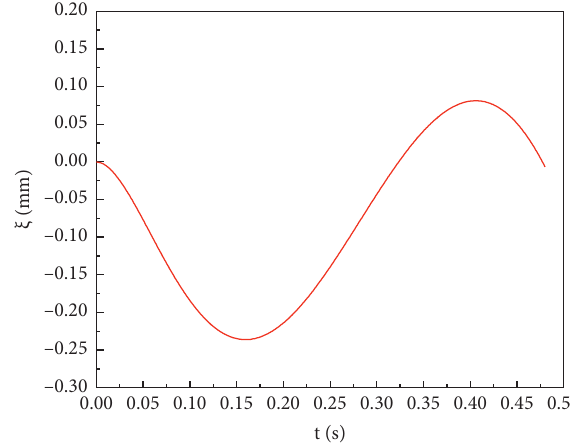
Figure 8: The relationship between the displacement differences between the carbon brush and the slip ring with respect to